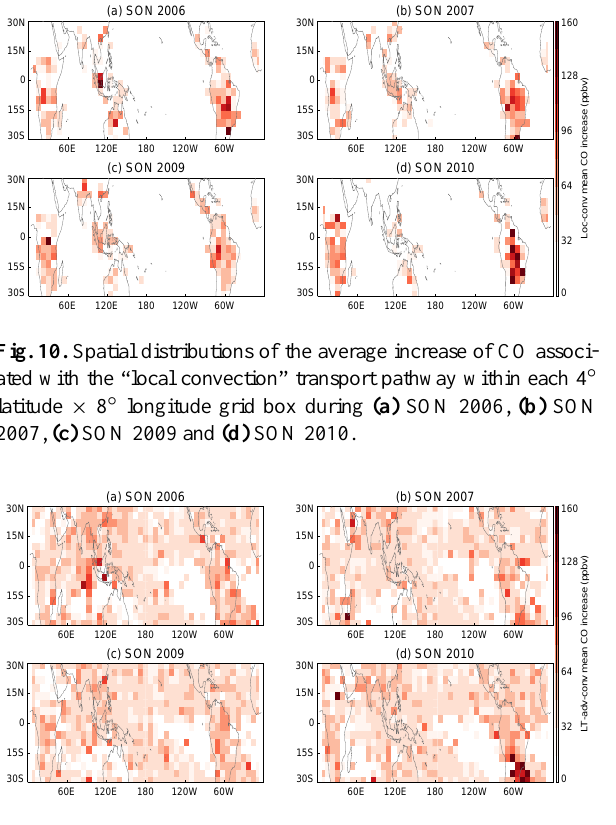
Fig. 9. As in Fig. 8, but for the “LT advection → convection” trans- port pathway.